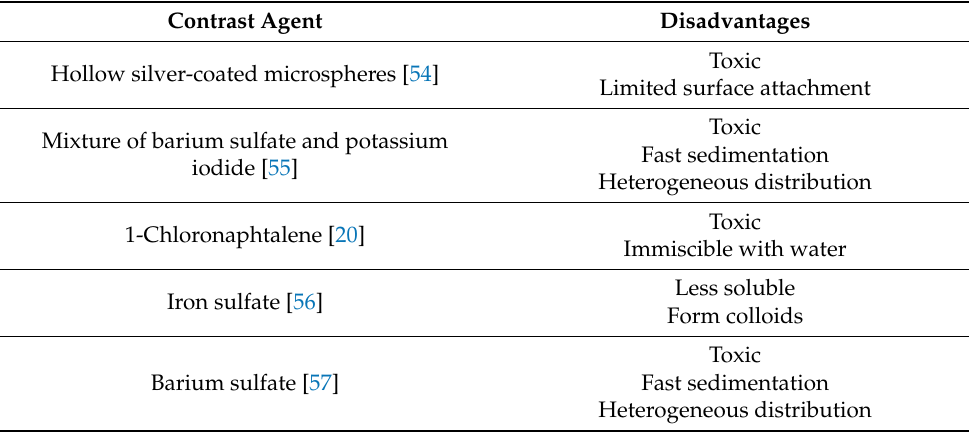
Toxic Limited surface attachment